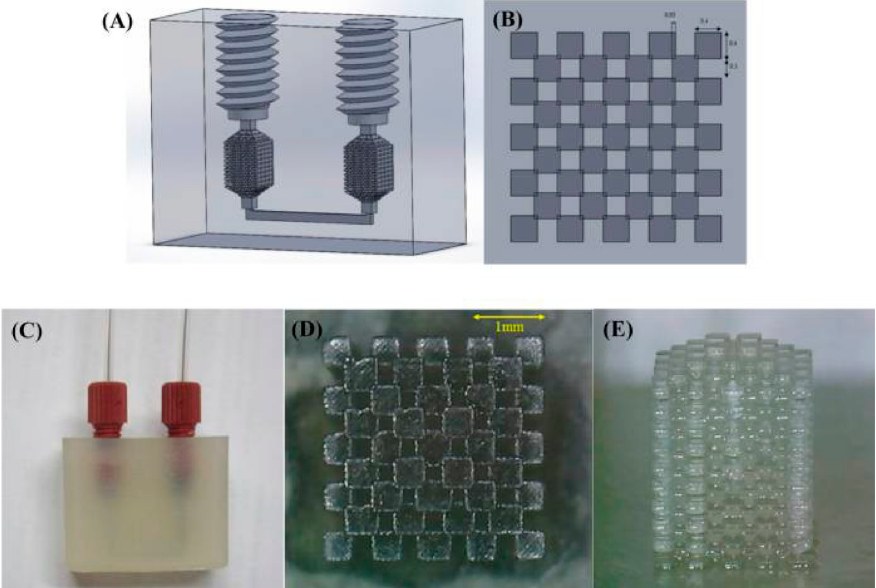
Figure 8. ( A , B ) Computer Aided Design (CAD) drawings of the ( A ) pre-concentrator and ( B ) a layer of ordered cuboids in the extraction channel; ( C ) Photograph of the printed device; two flat-bottom female connectors with a piece of Poly Tetra Fluoro-Ethylene (PTFE) tubing were fitted to allow connection to an Flow Injection Analysis (FIA) interface; ( D , E ) Photographs of the configuration of the ordered cuboids printed without the surrounding of the extraction channel. Reproduced with permission from [54], Copyright (2015) American Chemical Society.